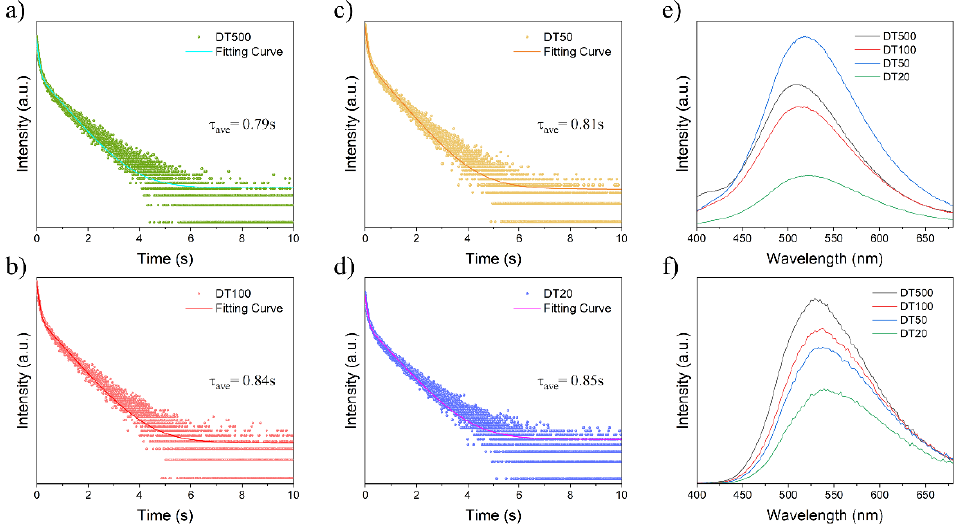
Figure 3. Room temperature phosphorescence decay curve and lifetime ( a ) DT500, ( b ) DT100, ( c ) DT50